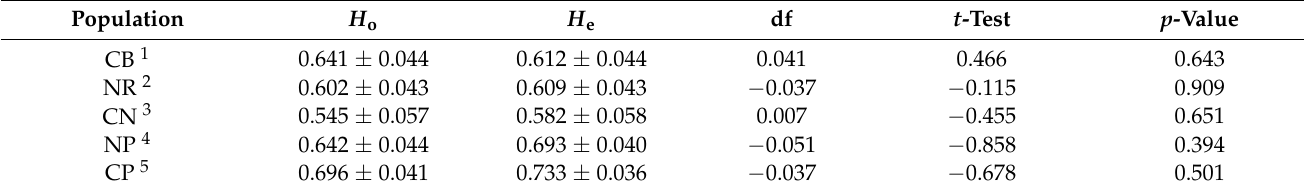
Table 2. Welch’s t -test of observed heterozygosity ( H o ) and expected heterozygosity ( H e ) of Siamese ( Crocodylus siamensis , Schneider, 1801) [1] and saltwater crocodiles ( Crocodylus porosus , Schneider, 1801) [13] based on 22 microsatellite